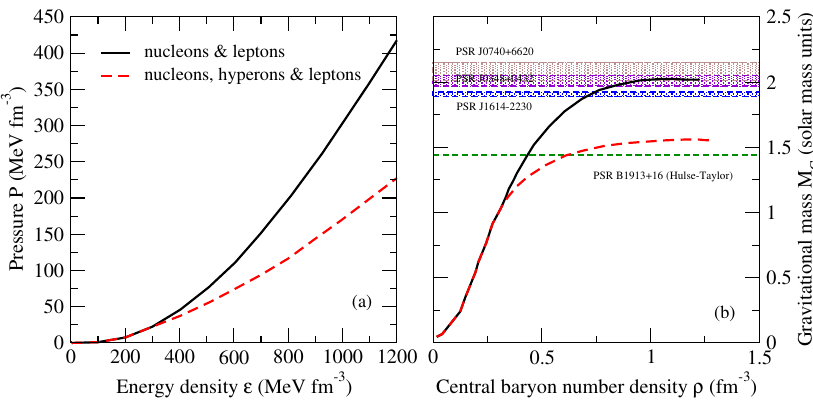
Figure 1. Illustration of the e ff ect of the presence of hyperons on the EoS (panel (a)) and mass of a neutron star (panel (b)). The GM3 parametrization of the Glendenning–Moszkowski RMF model (see Ref. [7]) with (red dashed line) and without (black solid line) hyperons has been considered as an ex- ample. The bands show the observational masses and their corresponding errors of the PSR B1913 + 16 (Hulse–Taylor) [18] pulsar, and the millisecond pulsars PSR J1614-2230 [3], PSR J0348 + 0432 [4] and PSR J0740 + 6620